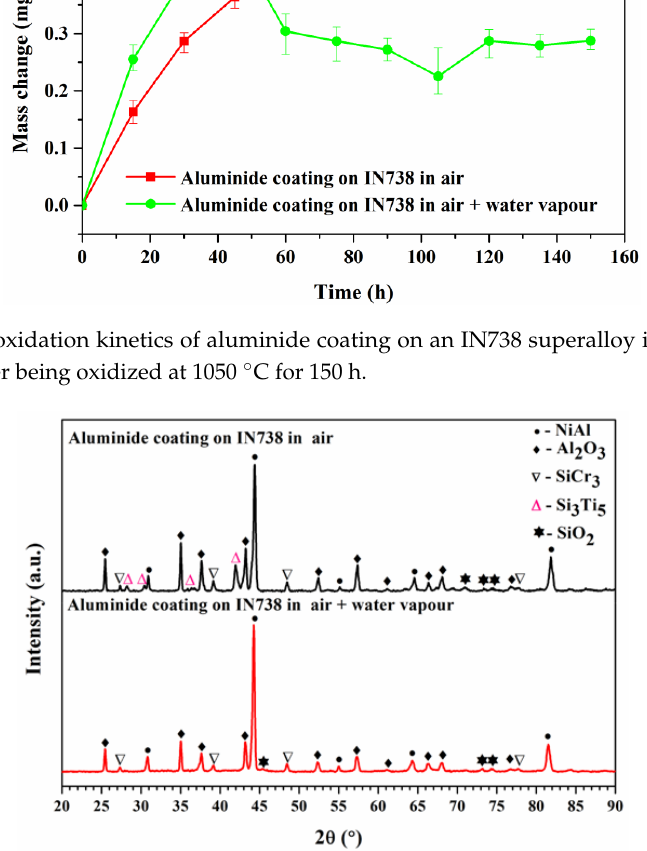
Figure 2. Surface X-ray diffraction (XRD) patterns for the aluminide coating on IN738 superalloy after 150 h of cyclic oxidation.